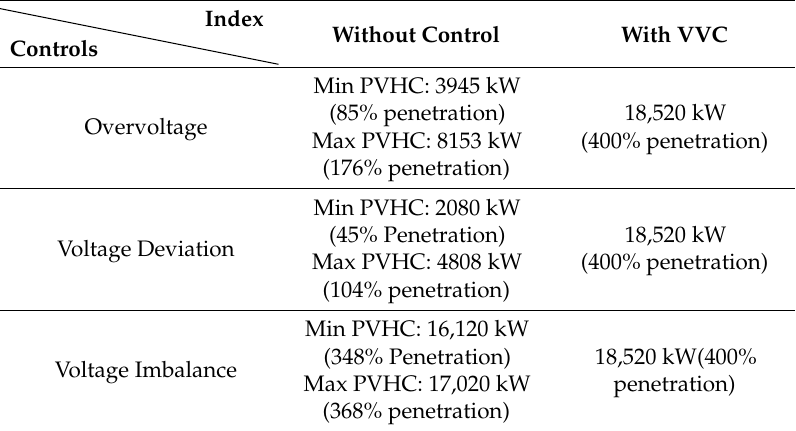
Table 3. PVHC analysis results with PV inverter enhancement